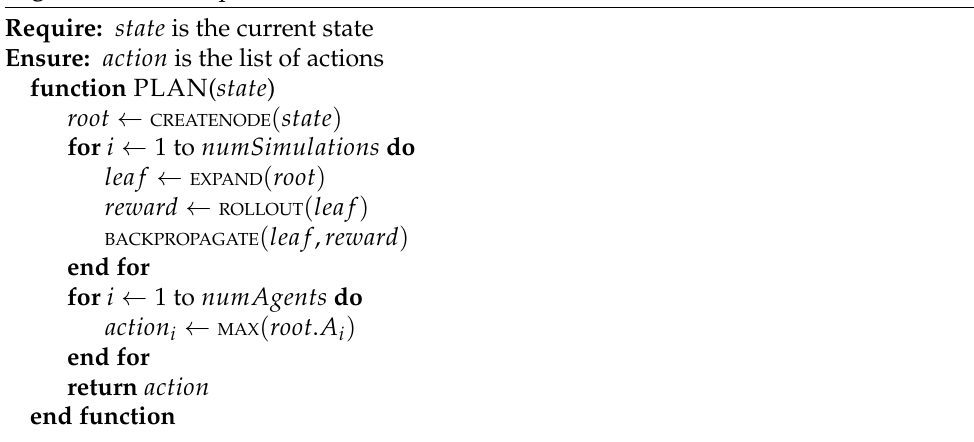
Algorithm 1 Decoupled Monte Carlo Tree Search